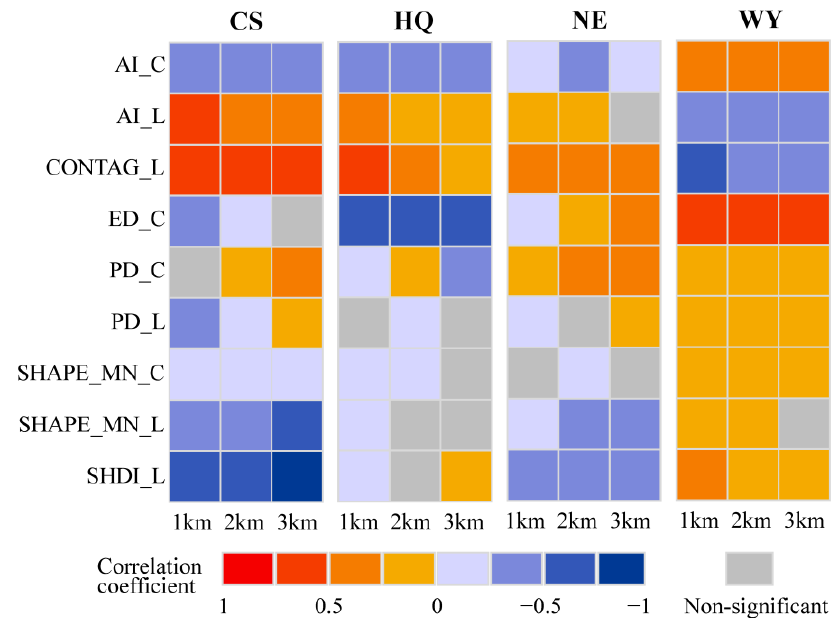
Figure 4. Correlation matrix between ESs and landscape pattern metrics at the landscape level and class level at different scales in Huainan. class level at different scales in